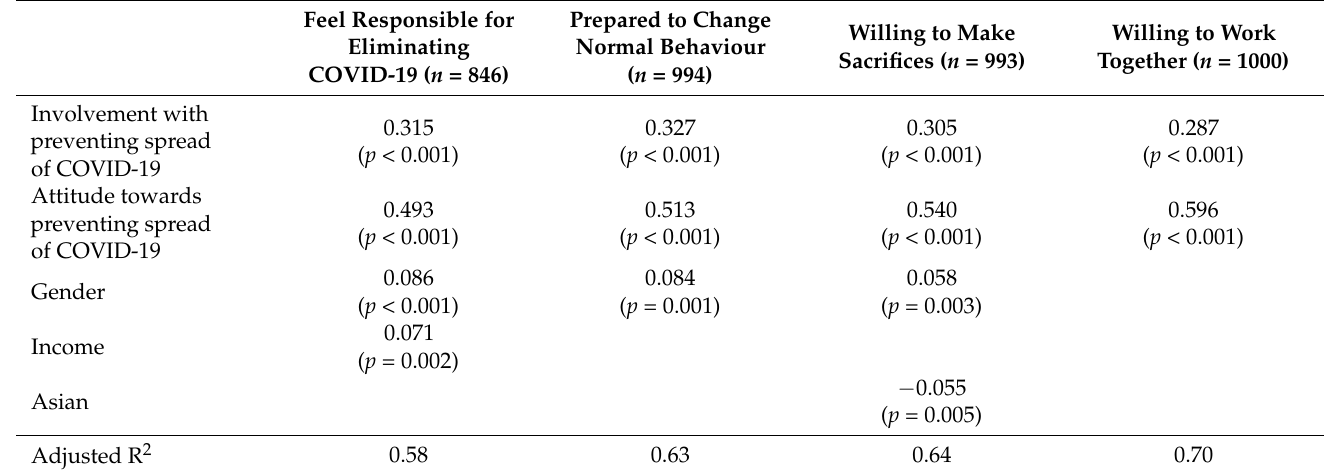
Table 6. Standardised parameter estimates for behavioural intentions.